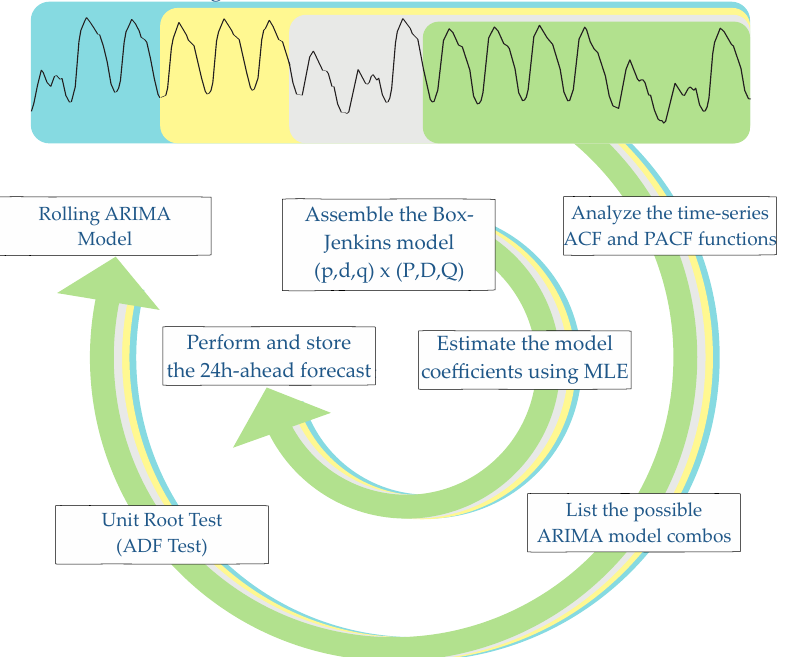
Figure 3. Predictions models: outline of the different stages from data selection to ARIMA